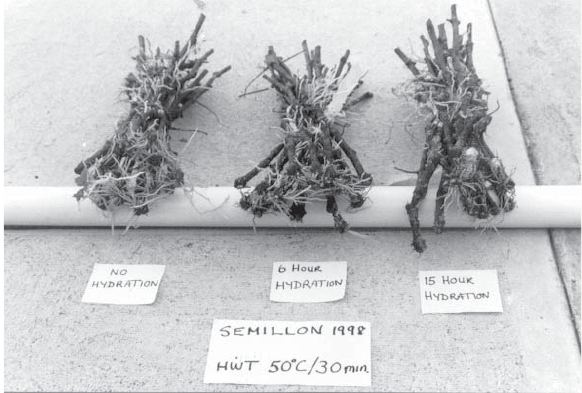
Fig. 1. Callused Semillon cuttings subjected to 0, 6 and 15 hours hydration prior to